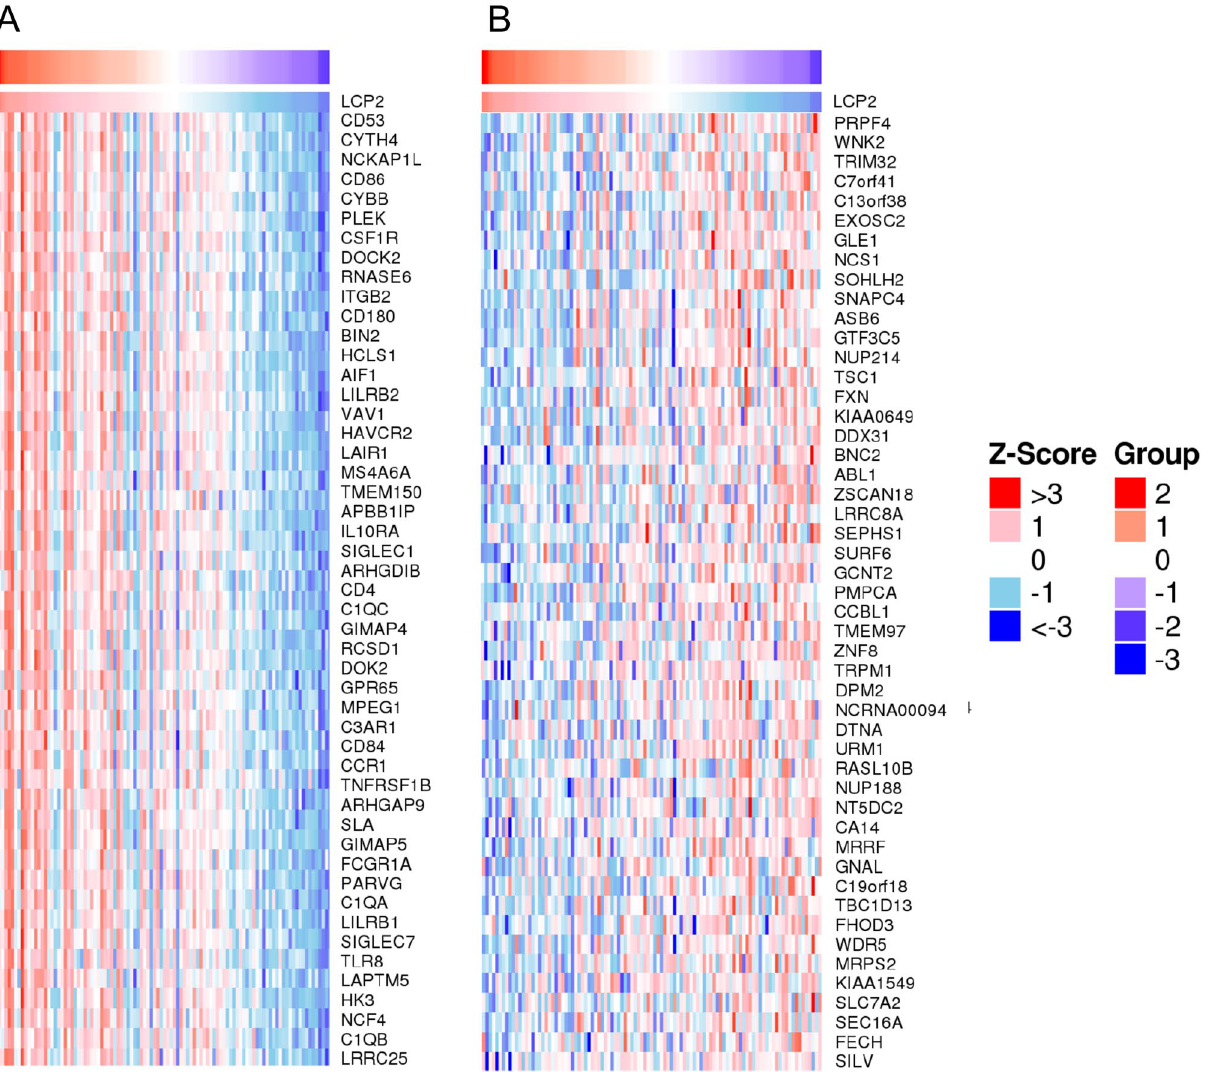
Figure 4. Heatmaps of LCP2 -correlated genes. ( A ) Heatmap of top 50 positively correlated genes. ( B ) Heatmap of top 50 negatively correlated